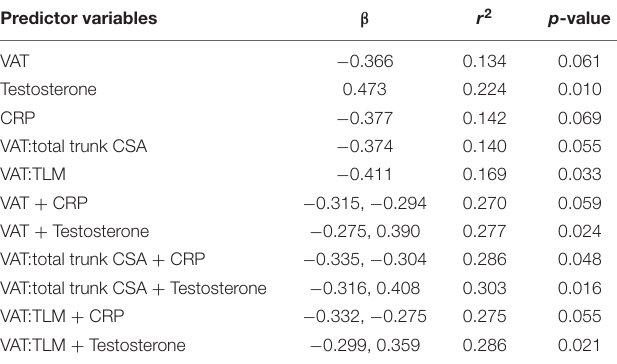
TABLE 5 | Single and multiple regressions predicting Complex III activity. Predictor variables